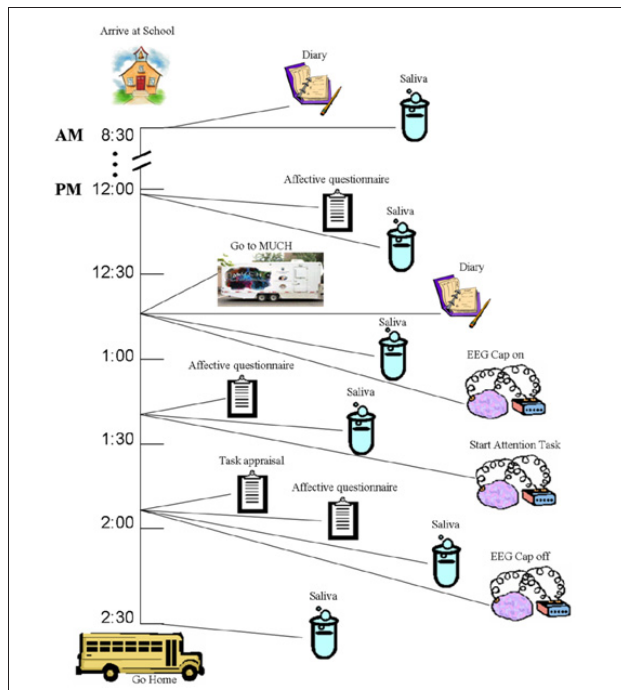
FIGURE 1 | Schematic representation of design and timeline of the study (see text for more